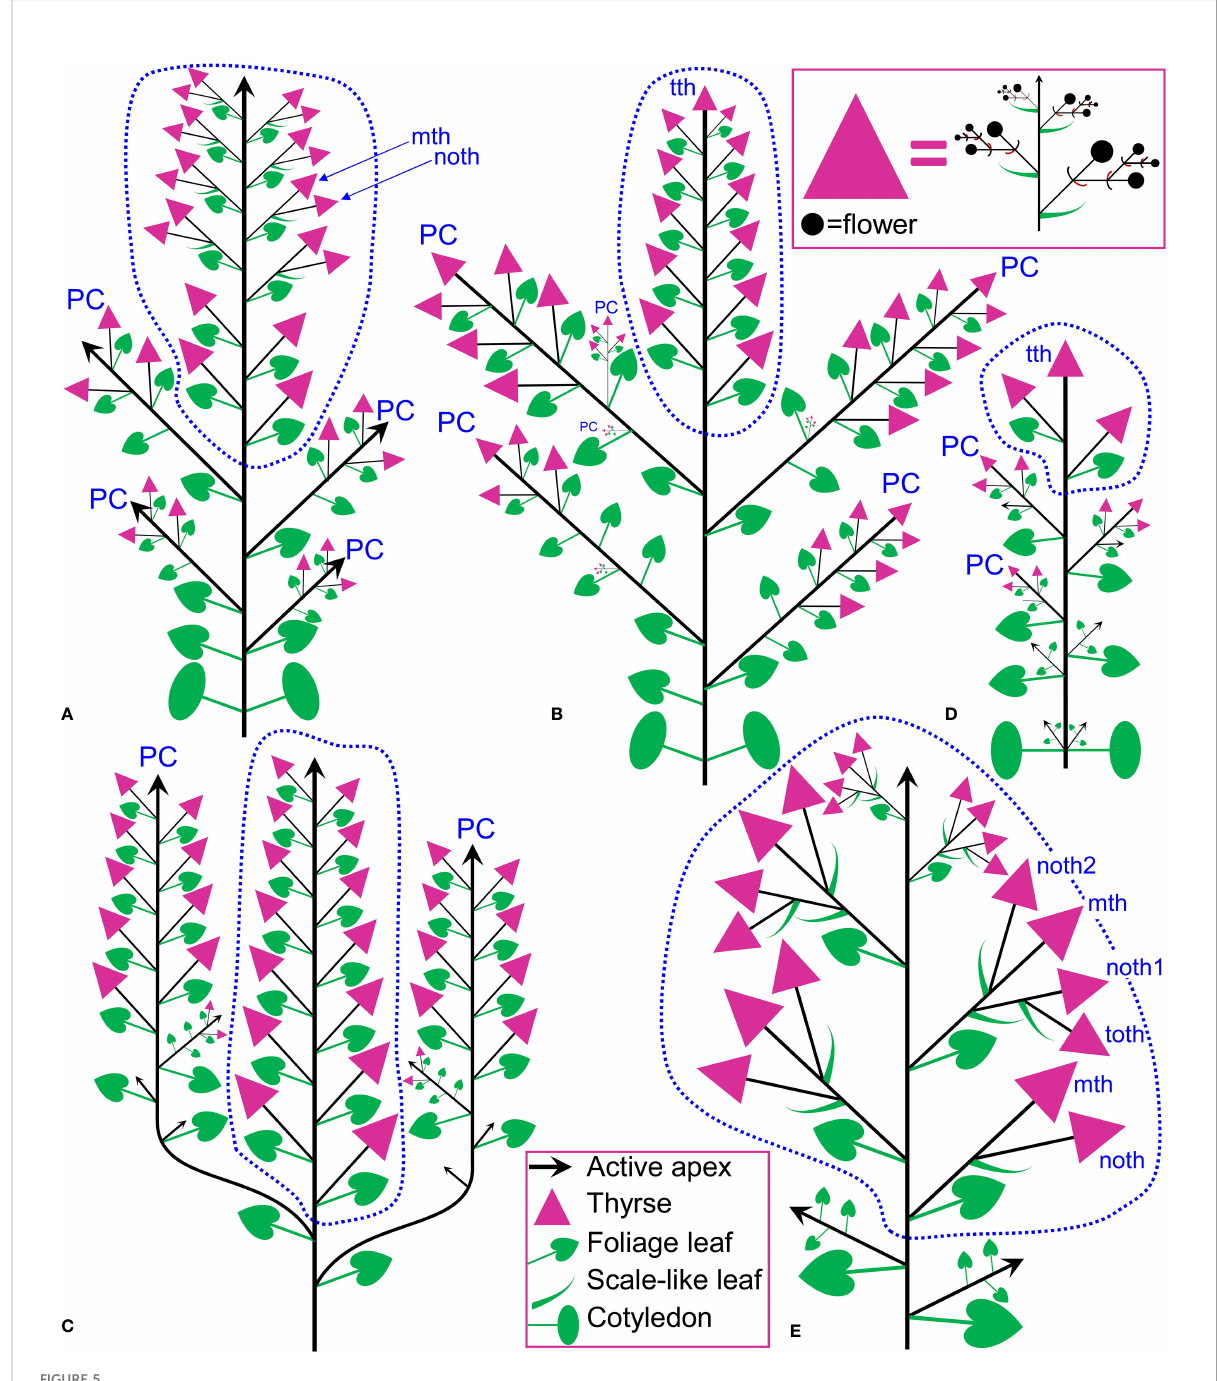
FIGURE 5 In fl orescence diagrams. (A) Fagopyrum tataricum , accession K17, entire plant cultivated in the same conditions as the plant in (B) and examined at a similar developmental stage (measured by the number of leaves on the main axis). With subsequent growth, the plant will ultimately produce a terminal thyrse. (B) Fagopyrum tataricum , accession C9119, entire plant illustrated Figure 7. (C) Fagopyrum esculentum subsp. ancestrale , upper part of in fl orescence. There are more paracladia of similar structure, but shorter than the two illustrated here, in axils of lower leaves of the main axis. Such paracladia are present in axils of cotyledons, too. (D) Fagopyrum esculentum subsp. esculentum cv. Dozhdik, entire plant. (E) Fagopyrum cymosum , upper part of shoot system based on the herbarium specimen illustrated in Figure 6A, (B) Dashed line, terminal fl owering unit; mth, main thyrse of a lateral group; noth, next order thyrse of a lateral group; PC, paracladium; toth, third order thyrse of a lateral group; tth, terminal